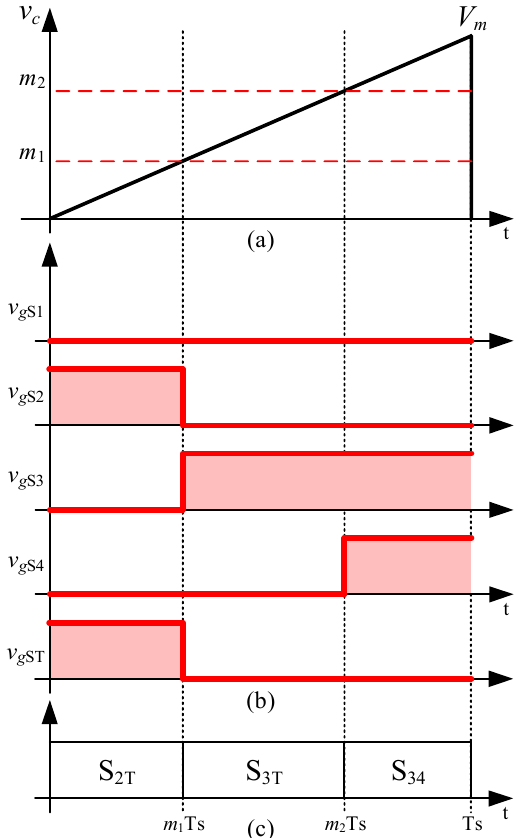
Figure 5. Forward mode: the carrier-based modulation scheme. ( a ) Carrier and modulating signals; ( b ) gating signals of the switches; ( c ) states of operation.